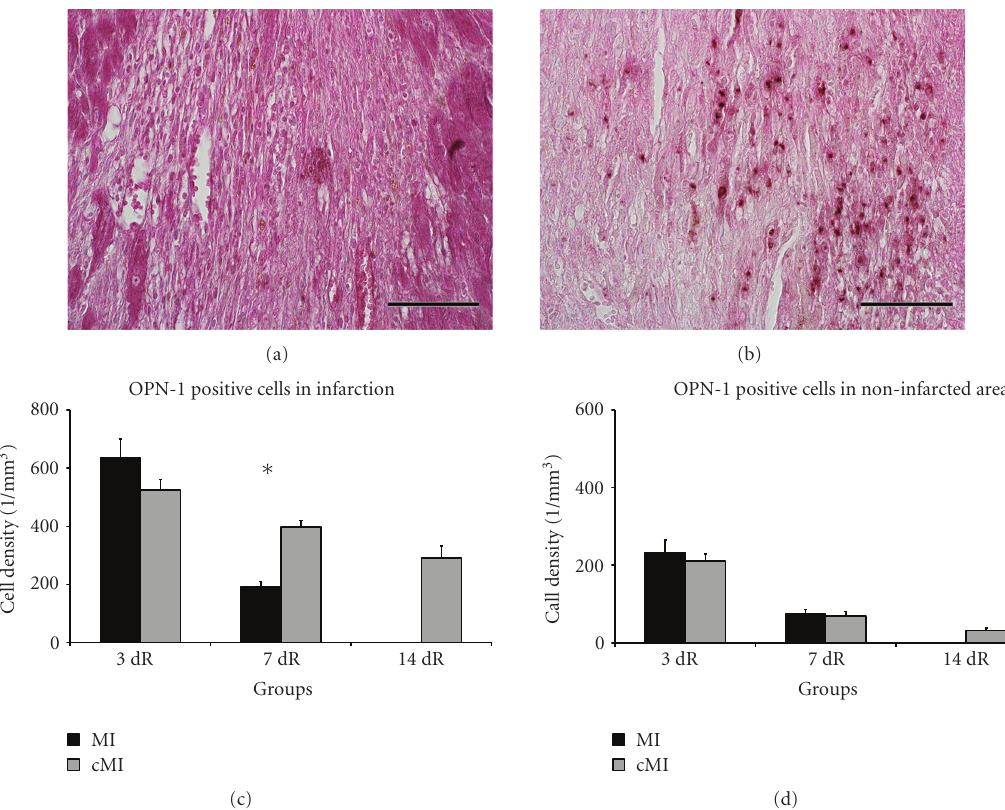
Figure 4: Osteopontin-1 in infarcted myocardium. Representative staining for macrophage maturation marker osteopontin-1 (black-stained cells) in left ventricular wall (eosin counterstaining) 7 days after (a) reperfused infarction (MI) and (b) cryoinfarction (cMI). Cell density of osteopontin-1-positive cells in (c) infarcted area and (d) noninfarcted area in both models. Scale bar: 75 μ m; ∗ P < .